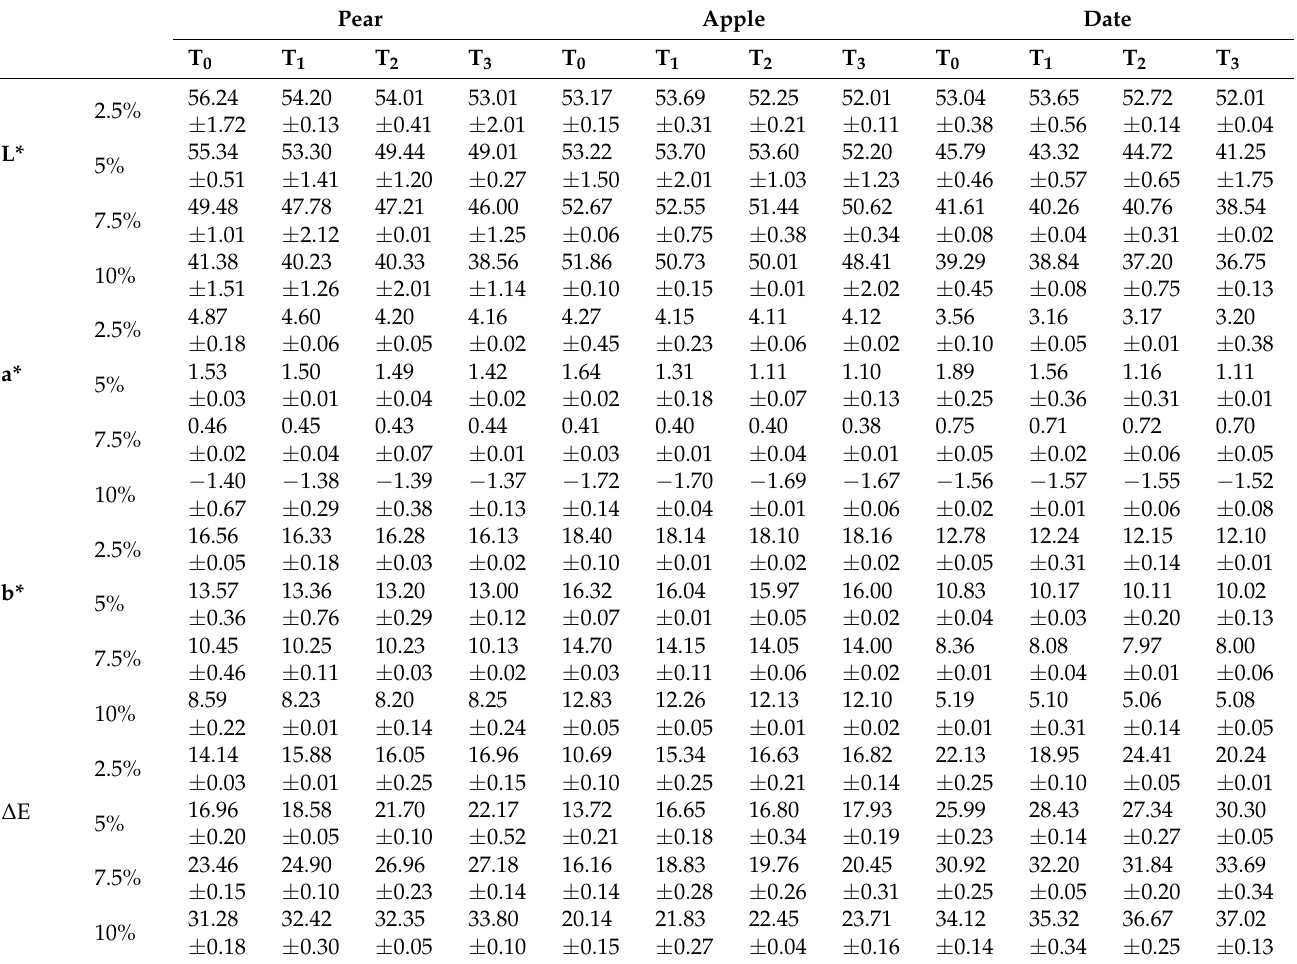
Table 4. Color parameters of enriched pasta during